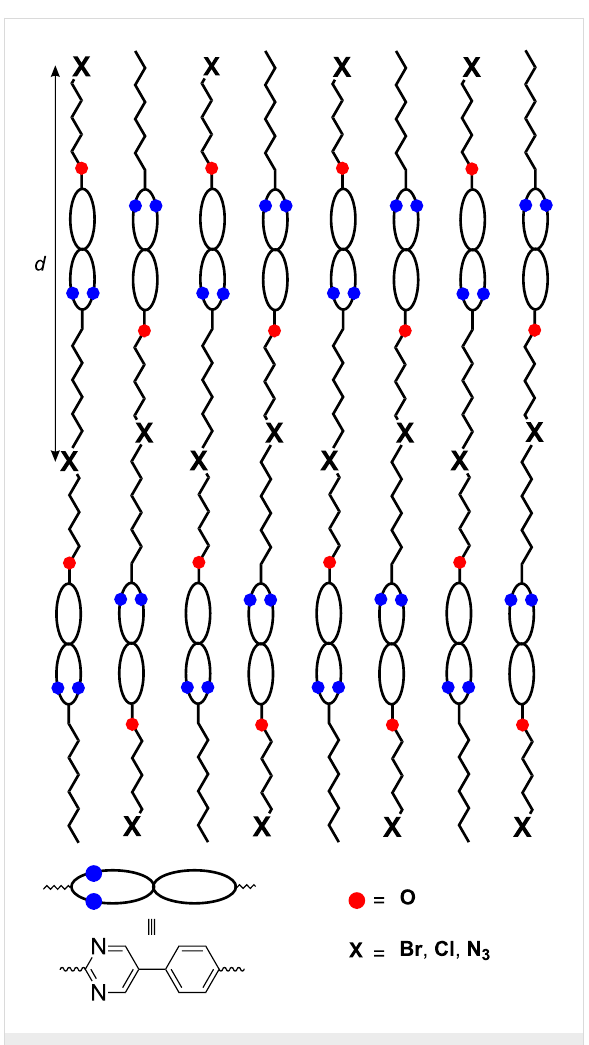
Figure 9: Proposed model for the layer